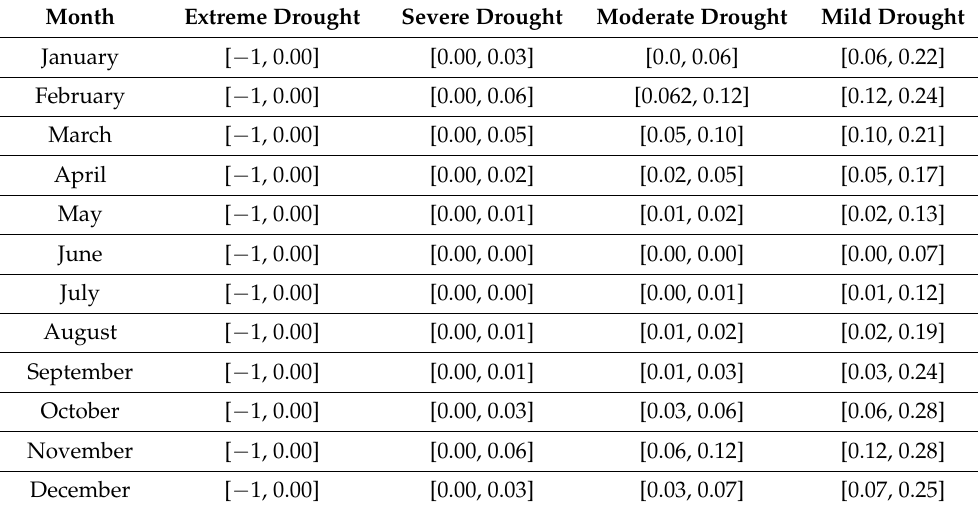
Table 8. The NDVI range for different drought categories for 12 months in 2015 (Temperate Region of Australia).